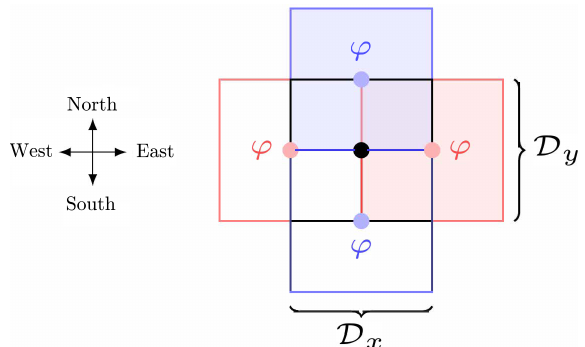
Figure A1. Averaging concept for the determination of larger-scale forcing terms from COSMO model output. The shifted domains (red and blue) are used for the calculation of larger-scale gradients of φ ∈{ θ l,LS , q t,LS } . The centered averaging domain (black) is used for the calculation of all other larger-scale